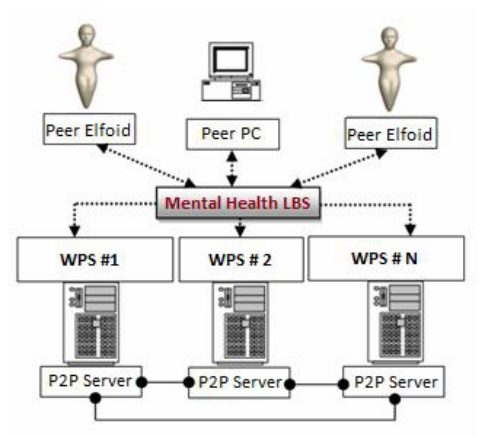
Figure 4. The P2P system Architecture